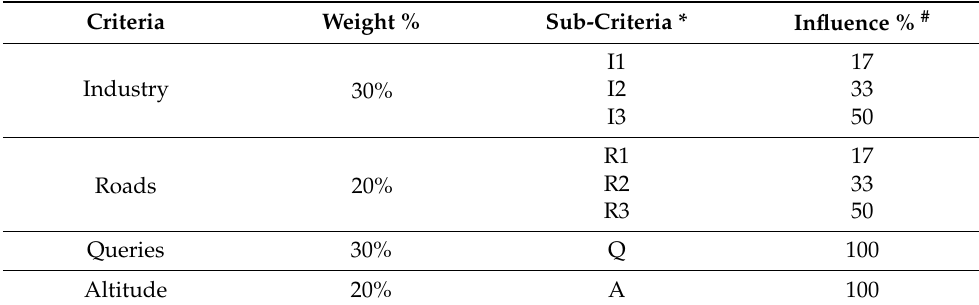
Table 1. Criteria and sub-criteria weights.